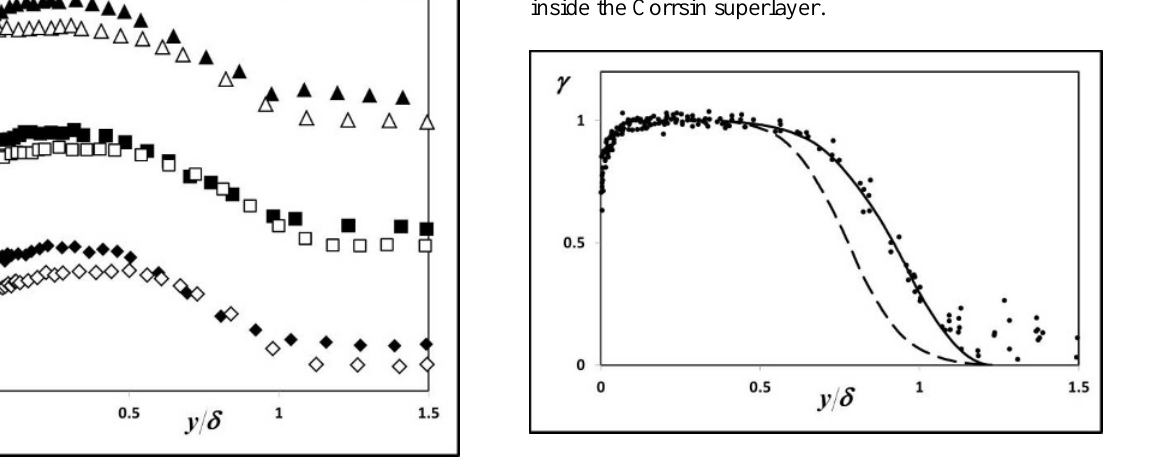
Fig. 10. Profile of the intermittency factor across turbulent boundary layer in natural FST (dashed line represents course determined by Klebanoff).